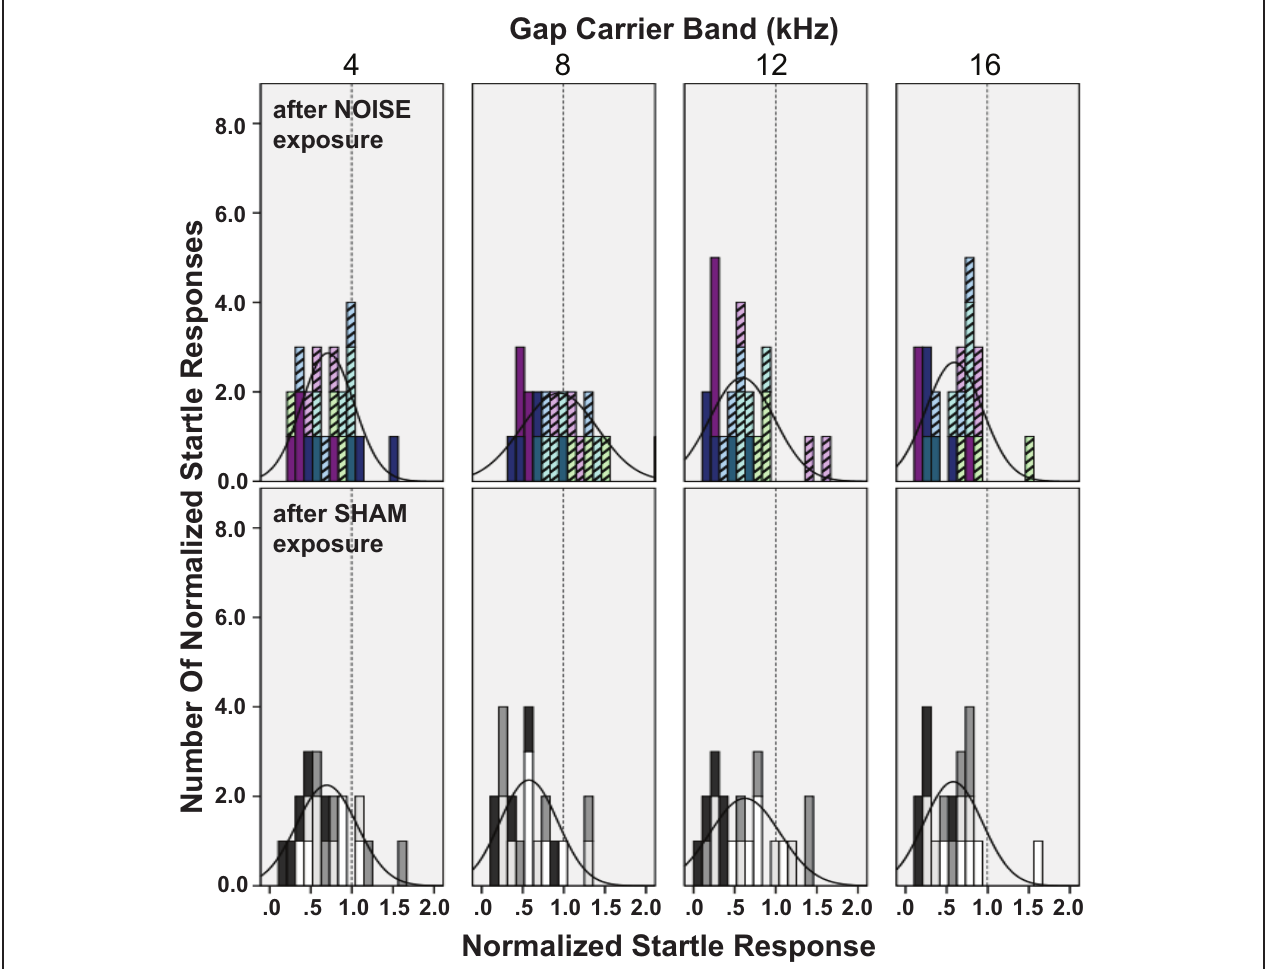
thresholds (2, 3, 3, 4, 4, 4 test days in the noise exposed groups and 5 days in the control group). Top row: noise exposed animals ( N = 7), bottom row: control animals ( N = 4). The individual animals’ data are identified by the color of the stacked histograms. Noise-exposed animals are grouped as “tinnitus” (light, pastel colored striped bars, N = 4) or “no tinnitus” (dark colored bars, N = 3). “Tinnitus” animals show normalized responses shifted toward higher startle values. The dotted line in each panel marks 1 (100%